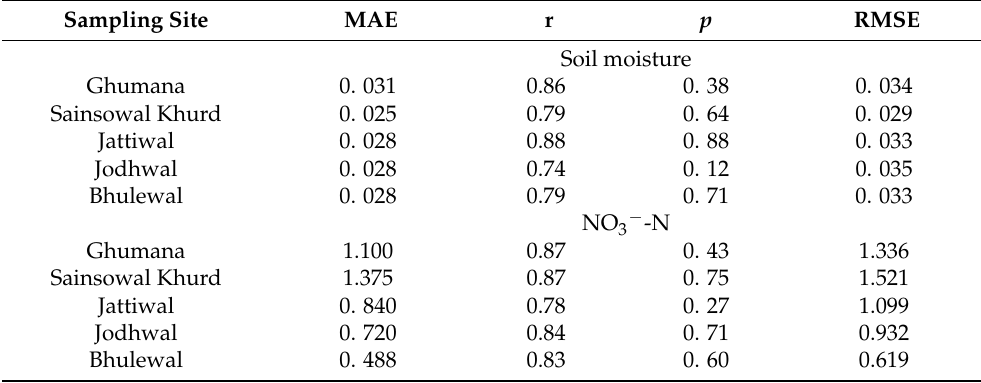
Figure 4. Predicted mean groundwater nitrate concentration of the study area for 2004–2005 rice-wheat cropping cycle. Table 3. Statistical comparison of measured and predicted values of soil moisture (cm 3 cm − 3 ) and NO 3 − -N concentration (mg kg − 1 ) across the soil profile during the validation of five sampling sites (Acronyms: MAE = mean absolute error, r = coefficient of correlation, p = Wilcoxon p -value of significant differences, and RMSE = root mean square